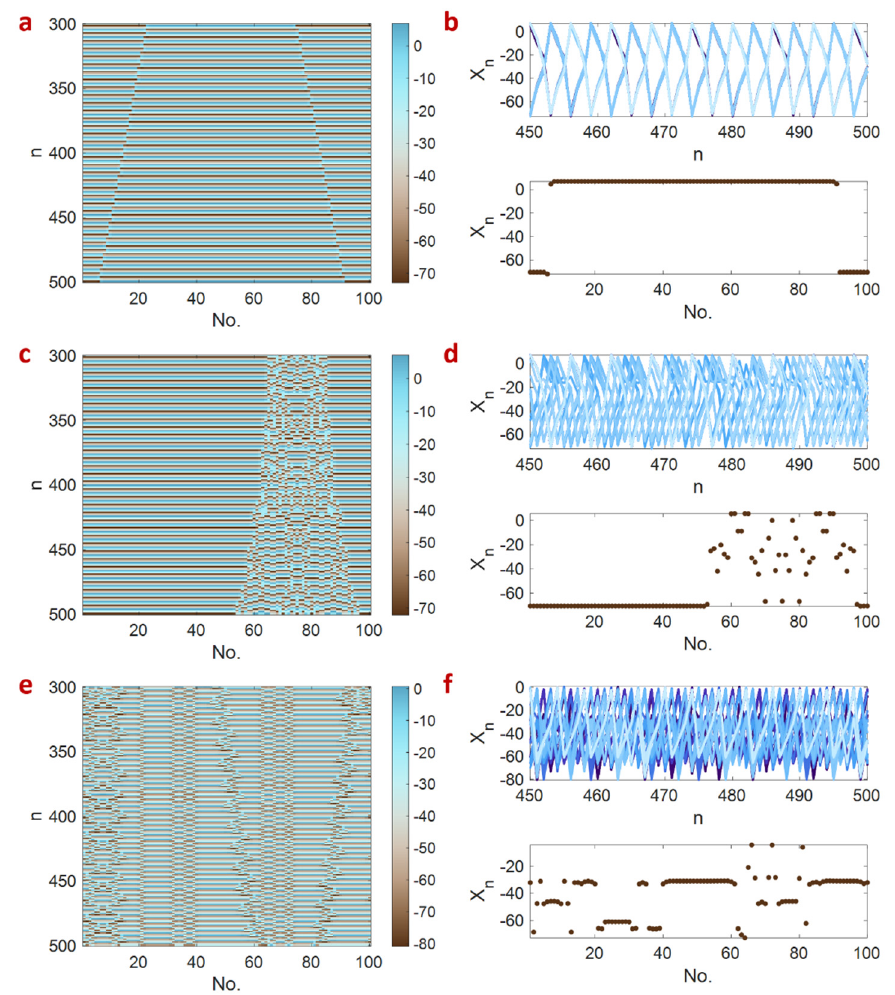
Figure 7. The spatiotemporal patterns (left panel) and the time series and snapshots (right panel) of the network of 100 memristive neuron maps coupled via electrochemical synapses. ( a , b ) For 𝑔 (cid:3030) = 0.07 and 𝜖 = 0.01 , imperfect synchronization is formed. ( c , d ) For 𝑔 (cid:3030) = 0.05 and 𝜖 = 0.05 , the chimera state is observed. ( e , f ) For 𝑔 (cid:3030) = 0.52 and 𝜖 = 0.11 , the nonstationary chimera appears.